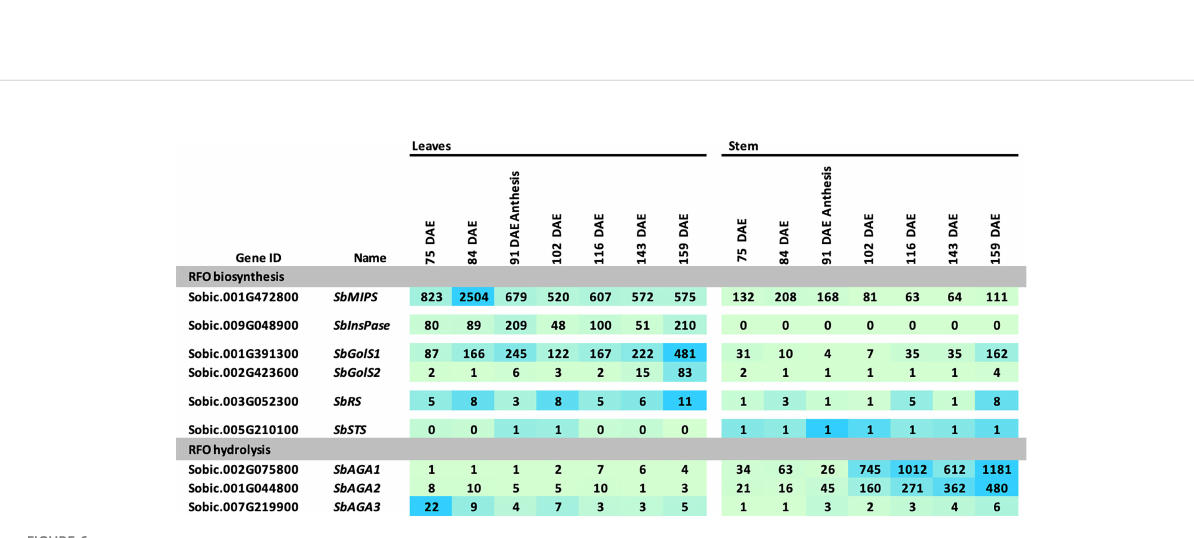
FIGURE 6 Expression of RFO metabolism genes in leaves and stems of Della during development. Samples were collected starting before anthesis and ending after grain maturity. Anthesis occurred at 91 DAE. Numeric data represents TPM normalized expression. Each data point is the mean of three biological replicates. In the heat map, the darker the blue the higher the